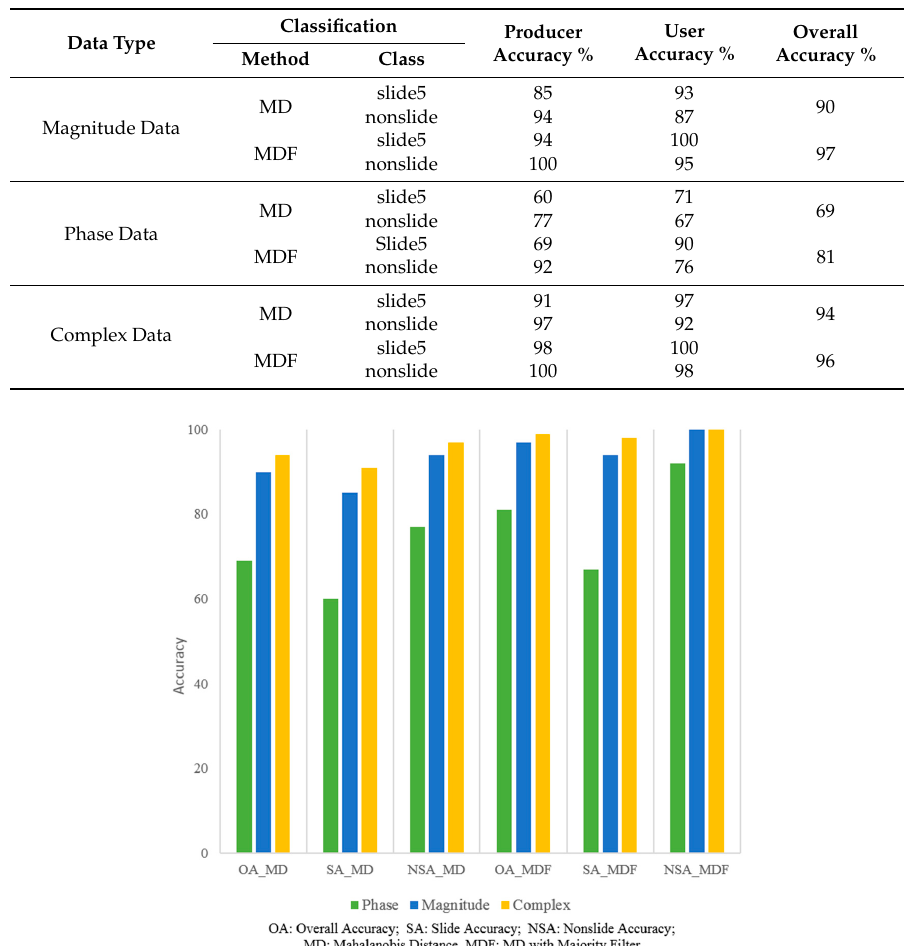
Figure 13. Phase data classification for the segment Sample 3: ( a ) without majority filter; ( b ) with majority filter; ( c ) optical image overlaid with slide and nonslide class shapes. Table 5. Accuracy analysis of the Mahalanobis distance (MD) classification and with majority filter (MDF) for slide and nonslide areas, of the segment Sample 3, using magnitude, phase, and complex data.